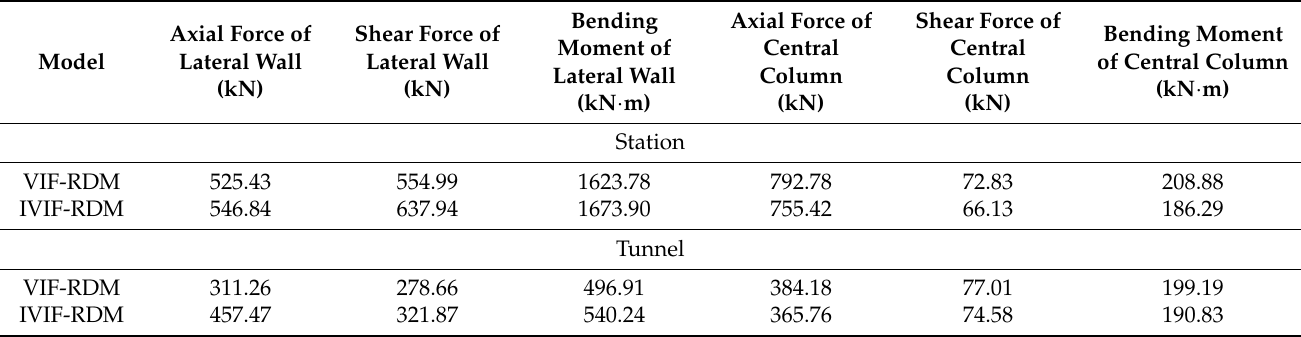
Table 2. Section force of the central column by different analysis methods.